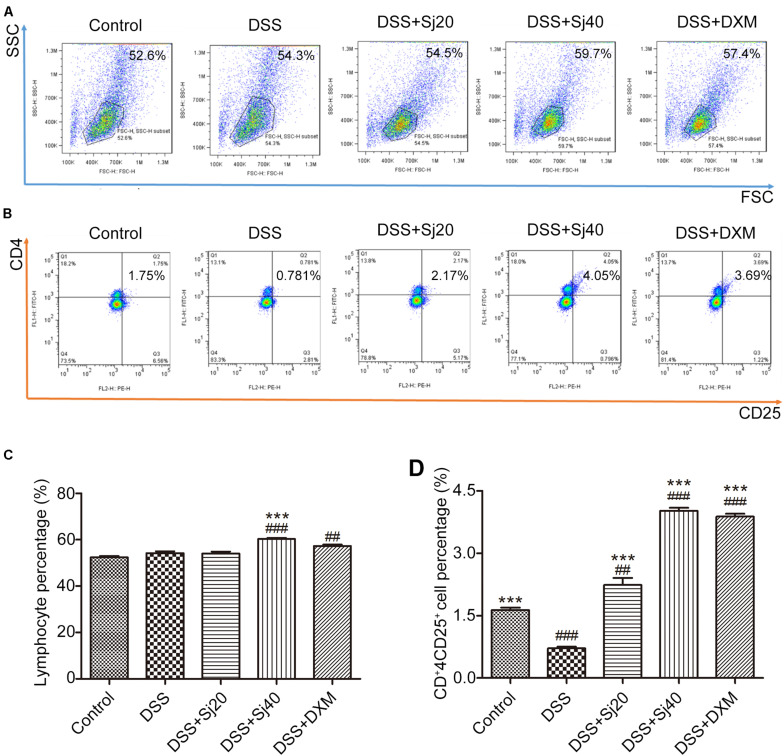
Mice treated with mSjci show elevated populations of lymphocytes and the CD4+CD25+ Treg cell subset. (A,B) The percentages of lymphocytes (A) and CD4+CD25+ Treg cells (B) was determined by flow cytometry. (C,D) The percentages of lymphocytes (C) and Treg cells (D) were quantified by flow cytometry analysis. The data (means ± SDs; n = 5 in triplicate) were analyzed by one-way ANOVA. ##p < 0.01, ###p < 0.001 compared with the control group; ***p < 0.001 compared with the DSS group.